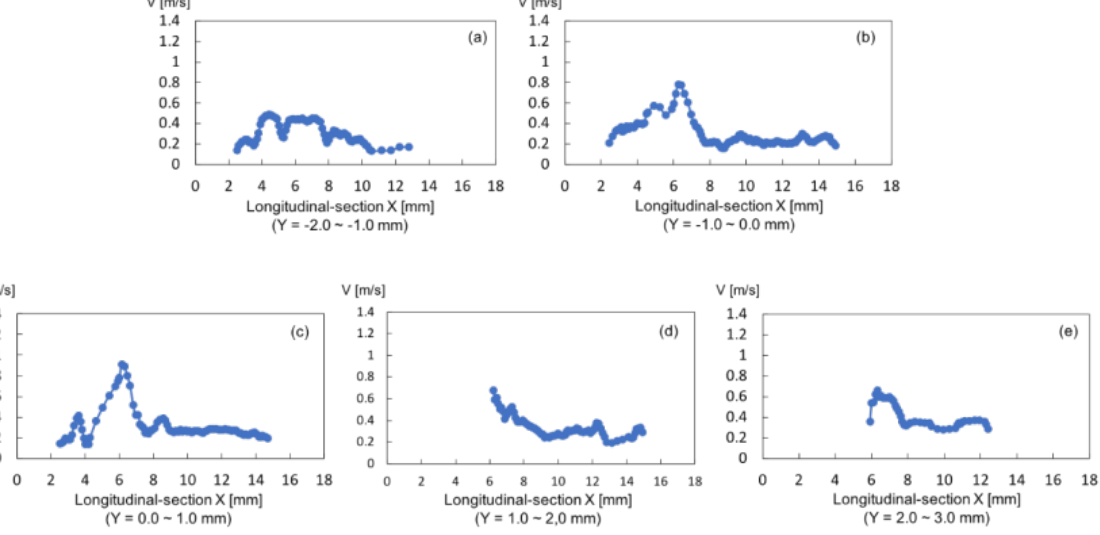
Figure 9. Flow velocity graph in the case of 120 A.